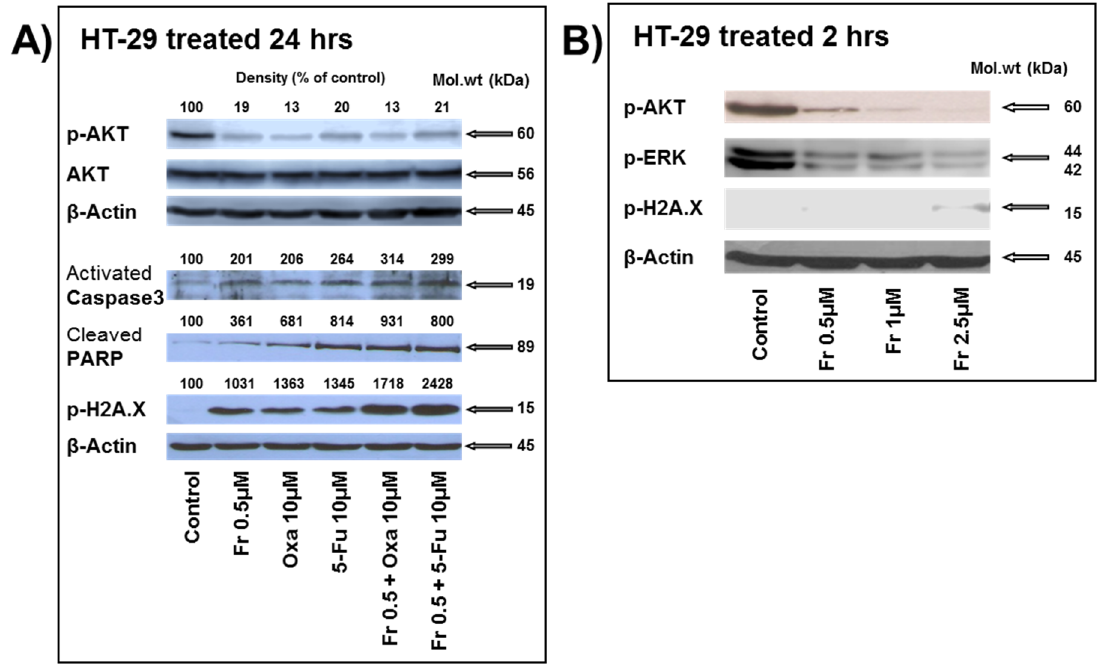
Figure 6. Western blot analysis of: ( A ) the effects of Frondoside A, oxaliplatin, 5-fluorouracil, and their combinations on the phosphorylation of the survival kinase AKT and on caspase-3 activation, Poly (ADP-ribose) polymerase (PARP) inactivation and H2AX phosphorylation. HT-29 cells were treated for 24 h with the indicated concentrations of Frondoside A, oxaliplatin, 5-fluorouracil, and their combinations. Densitometry analysis is from three different experiments. β-actin was used as an internal loading control of the protein levels, and the normalized bands’ densities are expressed as percentage change in comparison to control samples considered equal to 100%. ( B ) The levels of p-AKT, p-ERK, and p-H2AX after 2 h of treatment with Frondoside A (0.5–2.5 µM).